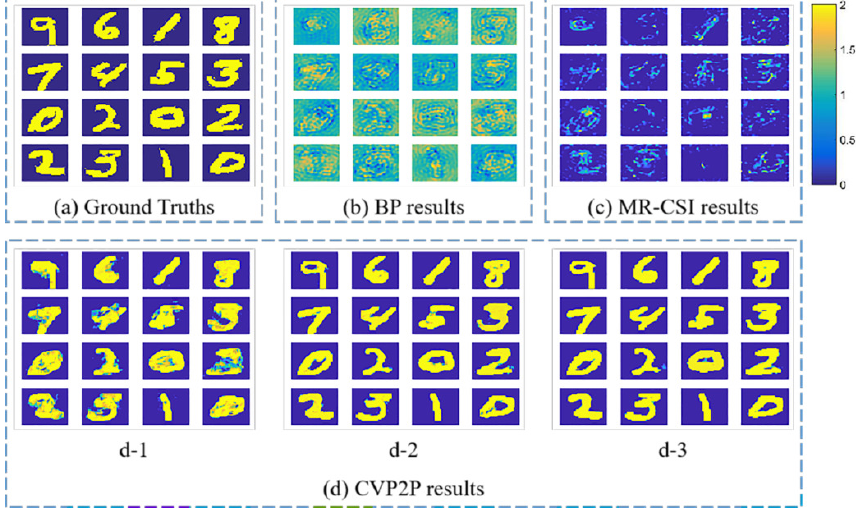
Figure 3. Example 1: Reconstructed results of contrast are obtained by different imaging algorithms. ( a ) Sixteen ground truths. ( b ) BP results, which are used as the input of CVP2P.( c ) MR-CSI results of 1000 iterations. ( d ) CVP2P results, where ( d-1 ), ( d-2 ), and ( d-3 ) represent the results of the cCNNs with three layers, six layers, and nine layers, respectively. Table 1. Peak signal-to-noise ratio (PSNR) results for the reconstructions in Figure 3. Ground Truths for Testing BP MR-CSI